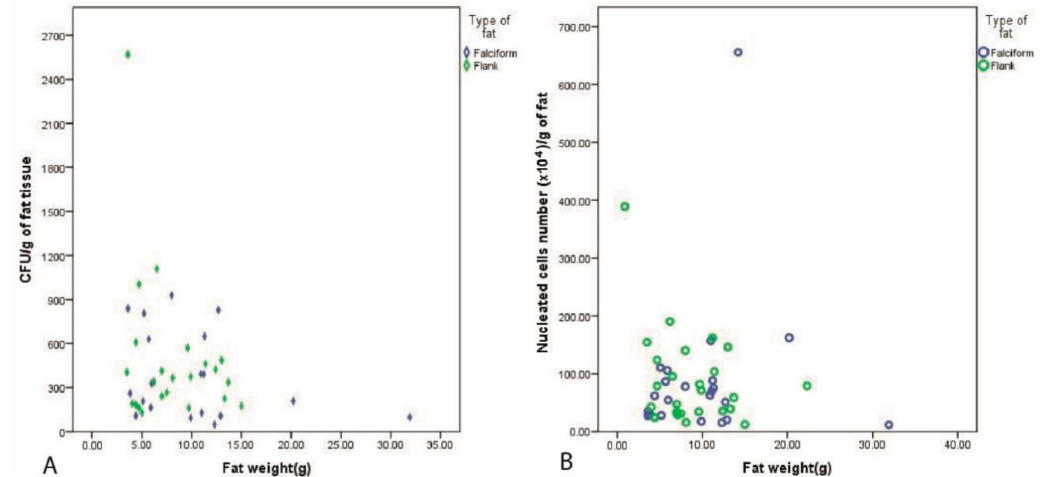
Figure 4. A positive Pearson’s correlation was observed between the harvested weight of the fat and quantified CFU/g for the fat from the flank (r = 0.478, p = 0.021), but this was not reported for the falciform fat. ( A ) Additionally, no correlation was recorded with the fat weight and nucleated cell number (SVF/g) ( B ).